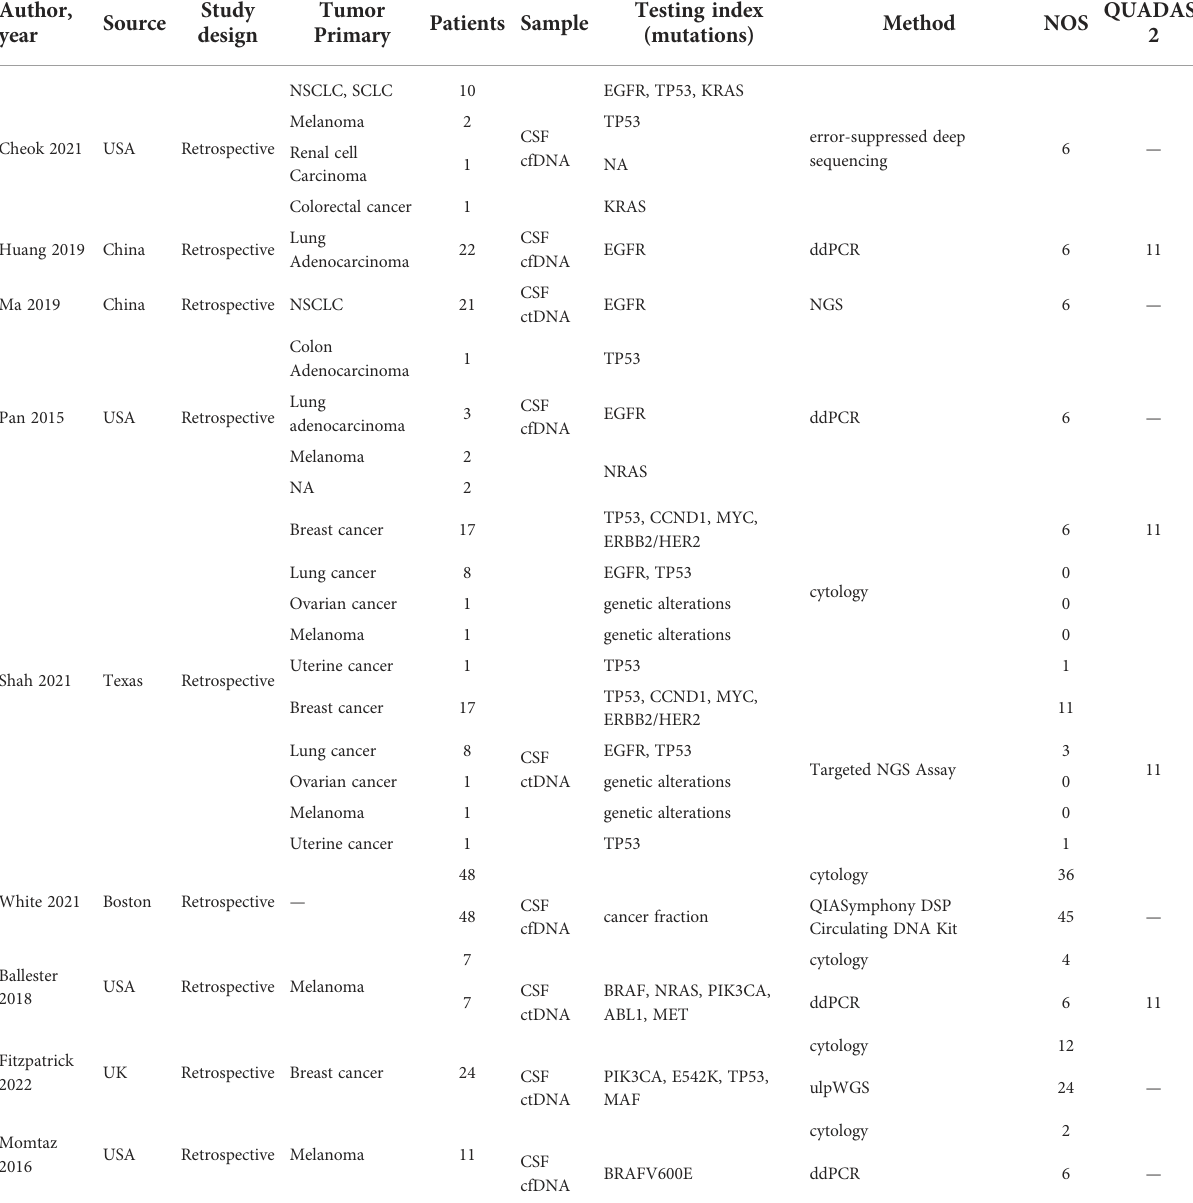
TABLE 1 Characteristics of studies included in this meta ‐